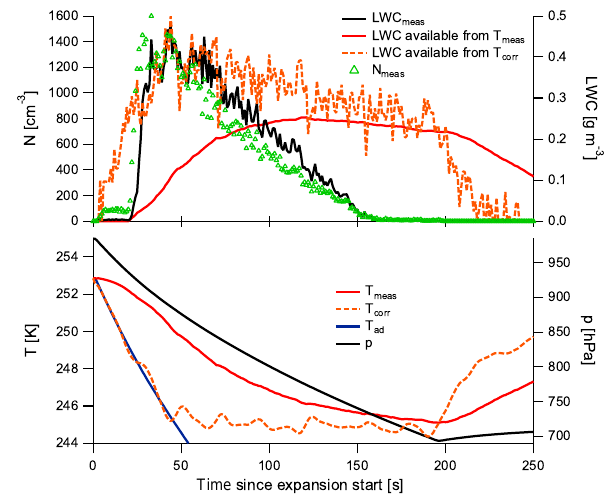
Figure A1. Measured and corrected temperatures and LWCs during the second heptadecane run of experiment 8 (cf. Table 1). See text for